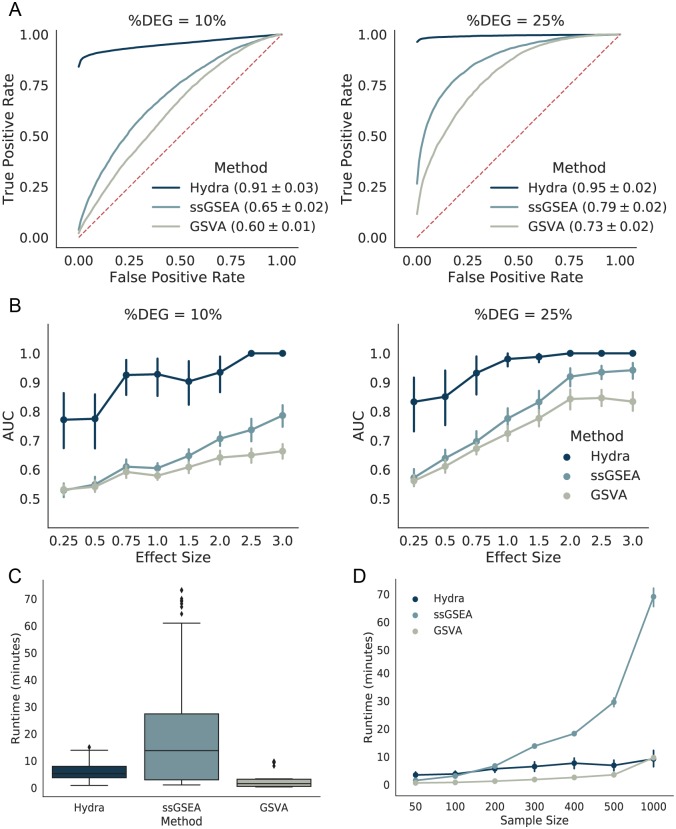
Hydra sweep is more sensitive than existing gene set enrichment approaches for detecting differential pathway expression in synthetic data and scales well to large datasets.A: Mean receiver operator curves across effect sizes, percent differentially expressed genes (%DEG), and MSigDB Hallmark gene sets. A larger area under the curve (AUC) indicates better performance. The average AUC and 95% confidence interval for each method are in the ROC plot figure legends. B: Line plots comparing the mean AUC across a range of effect sizes and %DEG values. C: Box plot showing mean runtimes for differential pathway analysis where the effect size is fixed but the sample size varies. D: Line plot comparing the mean runtimes for differential pathway analysis across a range of sample sizes.